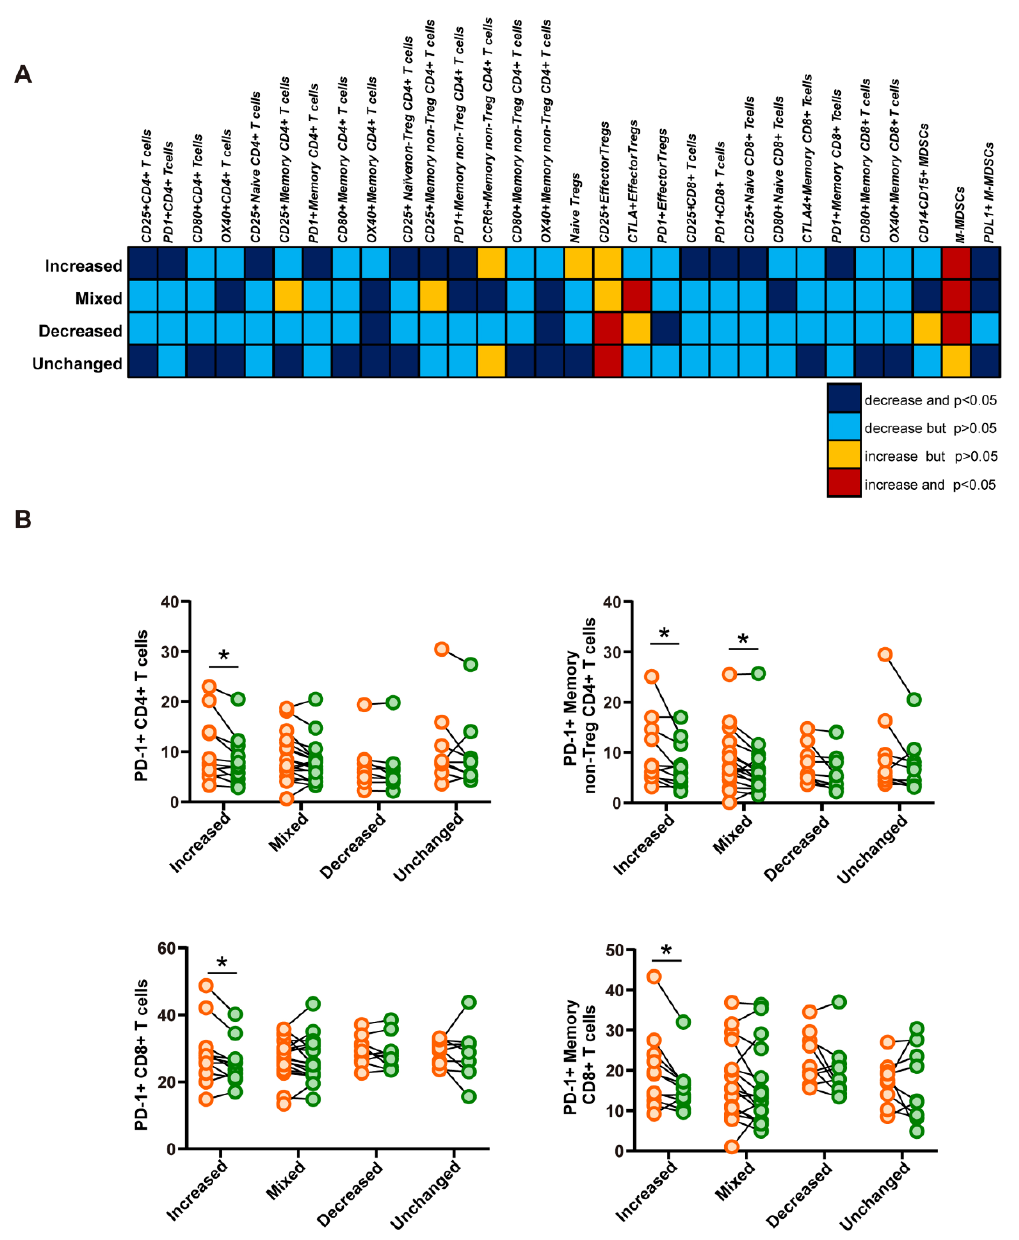
Figure 4. Relationship between TAA-derived peptide-specific immune responses and the frequency of immune cells with each immune phenotype. ( A ) Representative phenotypic variation map before and after treatment within the four groups classified based on the results of the ELISPOT assay. In comparisons with before the treatment with DAAs, changes in the frequency of T cells expressing each molecule after treatment are indicated separately by four different colors. ( B ) Dot plot displaying the frequency of PD-1-expressing T cells before (orange circle) and after (green circle) the treatment with DAAs within the four groups. The paired t-test was used to calculate p values. * p < 0.05.